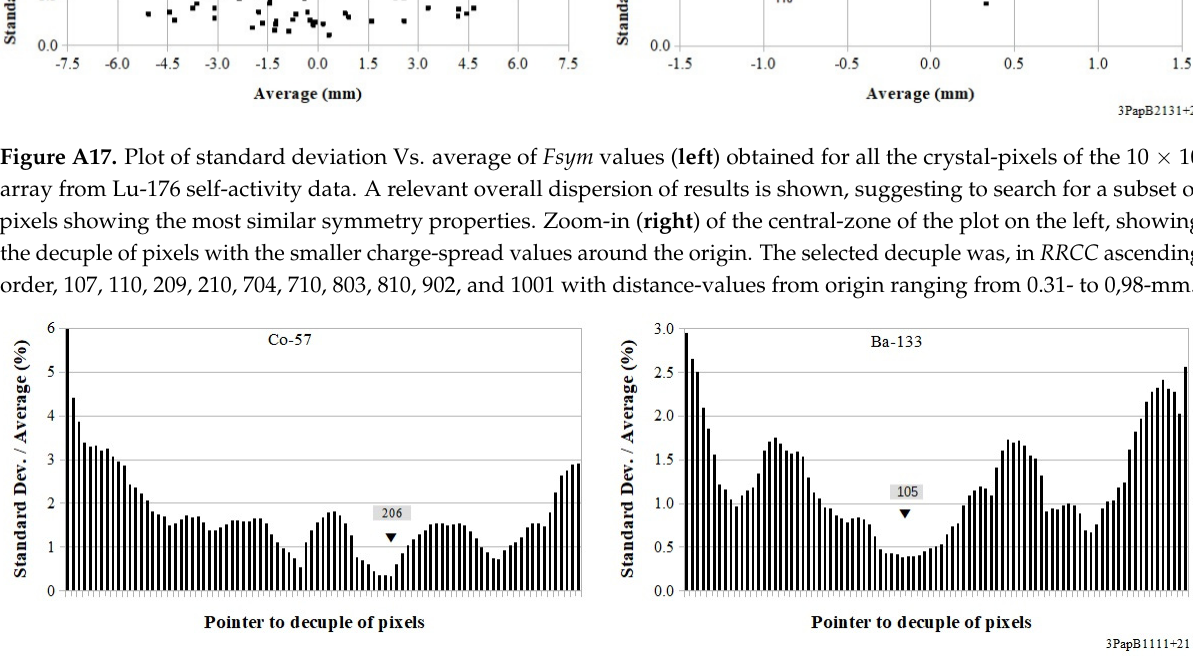
Figure A18. Plots of standard deviation to average ratios calculated for the decuples of adjacent net-charge pixel-values chosen along the entire set of 10 × 10 array of crystal-pixels, ordered by descending values for Co-57 ( left ) and Ba-133 ( right ), respectively. The solid triangles show the pointers to the minimum values of the ratios corresponding to the decuple made by 206, 207, 301, 304, 403, 406, 604, 709, 710, 809 pixels for Co-57, and by 105, 204, 206, 309, 405, 501, 503, 606, 608, 801 ones for Ba-133. The pixels are referred to by the RRCC notation.